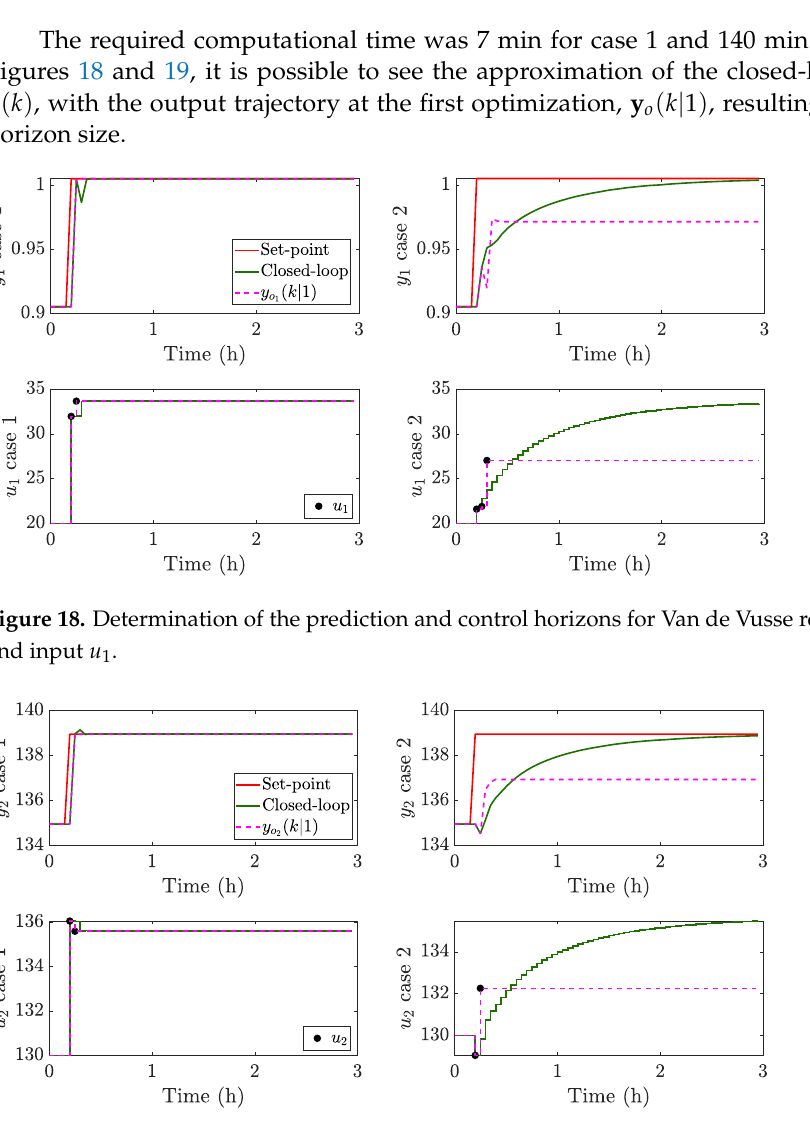
Figure 19. Determination of the prediction and control horizons for Van de Vusse reactor output y 2 and input u 2